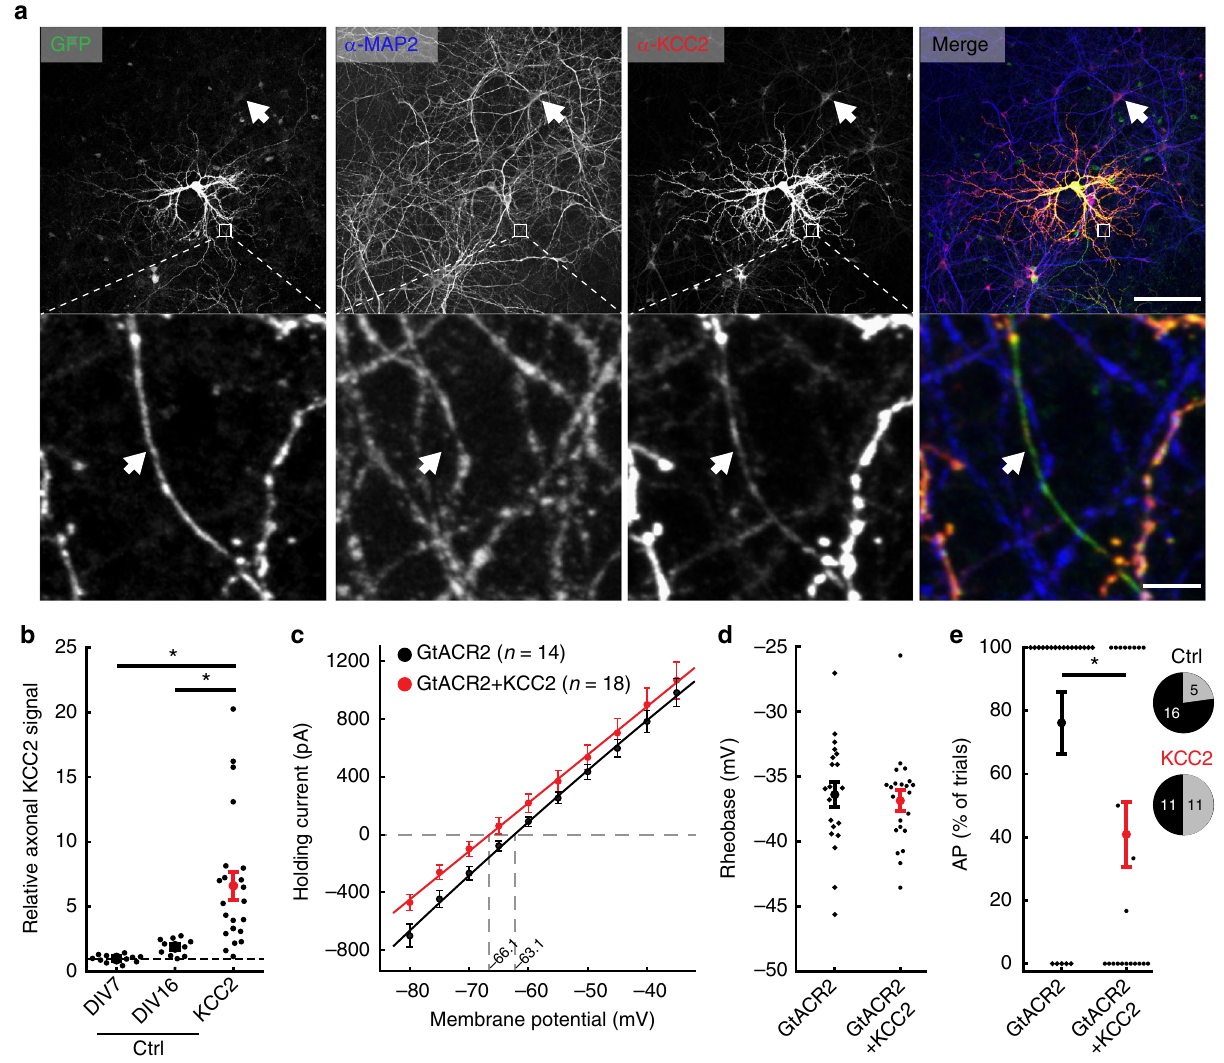
Fig. 2 Overexpression of KCC2 reduces antidromic spiking in cultured hippocampal neurons. a Images from a KCC2 overexpression experiment. Endogenous KCC2 is expressed in the somatic compartment, while overexpression of KCC2 led to increased expression in axonal projections. Cultured hippocampal neurons were sparsely transfected either with GFP alone (ctrl) or GFP and KCC2. Neurons were then fi xed and stained for MAP2 and KCC2. Top images show a representative region of interest with one overexpressing cell in the center. The arrow indicates a neuronal cell body expressing endogenous KCC2 levels at 16 days in vitro (DIV). Bottom images depict MAP2-expressing dendrites and a single MAP2-negative axon (arrow), which is positive for overexpressed KCC2 based on its anti-KCC2 fl uorescence. Scale bars, top: 150 µ m, bottom: 5 µ m. b Quanti fi cation of axonal KCC2 immuno fl uorescence for immature (DIV7) and mature control neurons (DIV16) and neurons overexpressing KCC2, normalized to the average axonal KCC2 signal in immature neurons (DIV7). Axonal KCC2 fl uorescence is signi fi cantly higher in KCC2-overexpressing cultures. (Kruskal – Wallis H-test, H (2,44) = 29.26, p < 10 − 4 ; ctrl: n = 11, n = 10, KCC2: n = 23) c – e Physiological properties and light-evoked spiking in cultured hippocampal neurons DIV7 DIV16 expressing either only GtACR2, or co-expressing KCC2. c Effect of KCC2 overexpression on the IV-curve. The reversal potential did not differ signi fi